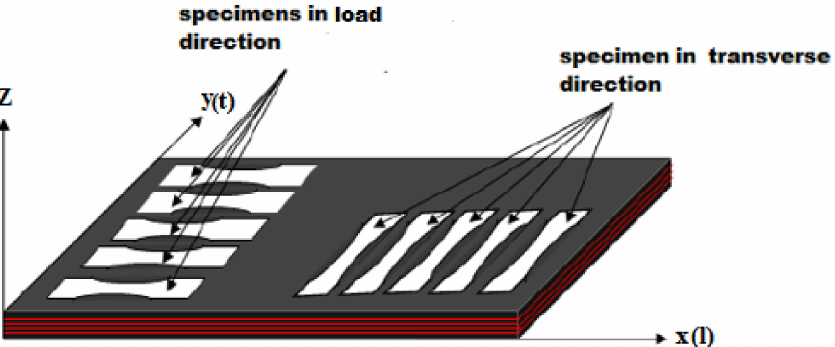
Figure 3. Beltviewofthetensilespecimendistributionwithrespecttolongitudinalandtransverse directions.